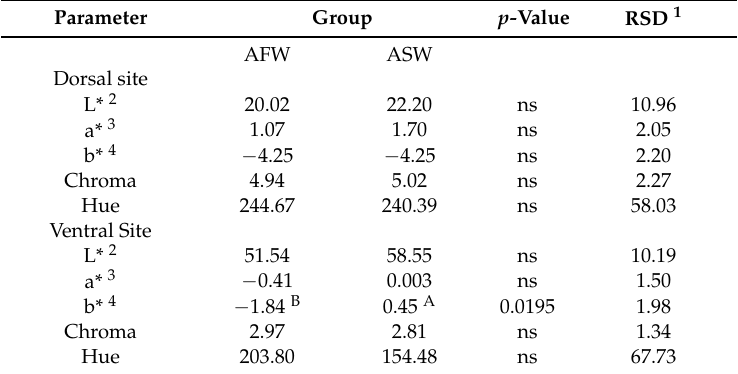
Table 2. Skin color at dorsal and ventral sites, in European sea bass reared in AFW and